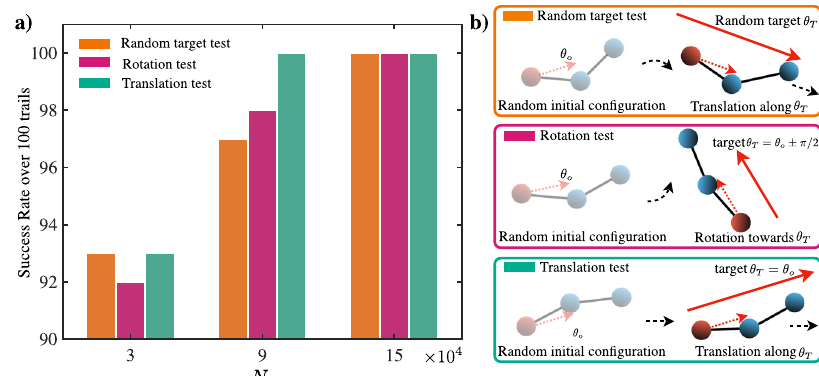
Fig. 4 Analysis of the swimmer ’ s performance with increasing number of episodes. Number of episodes N e indicates the total training time of the swimmer. Each episode during training contains a fi xed amount of action steps N l = 150. a We used three tests (random target test, rotation test and translation test) to measure the swimmer's performance in a fi xed number of training steps N l = 150. For all tests, the swimmer starts with a random initial con fi guration to ensure a full exploration of the observation space. A total of 100 trials are considered for each test with swimmers trained at different N e . A swimmer with insuf fi cient training (3 × 10 4 episodes) may occasionally fails in the three tests (success rate ≈ 90%). At N e = 9 × 10 4 , the swimmer masters translation and improves its rotation ability. When N e increases to 1.5 × 10 5 , the swimmer obtains a 100% success rate in all tests. b Schematics of the random target test, rotation test, and translation test. The leftmost sphere is marked as red and other spheres are marked as blue to indicate the swimmer's orientation θ o (red dashed arrows). Given a random initial con fi guration, we test the swimmer's ability to translate along or rotate towards a target